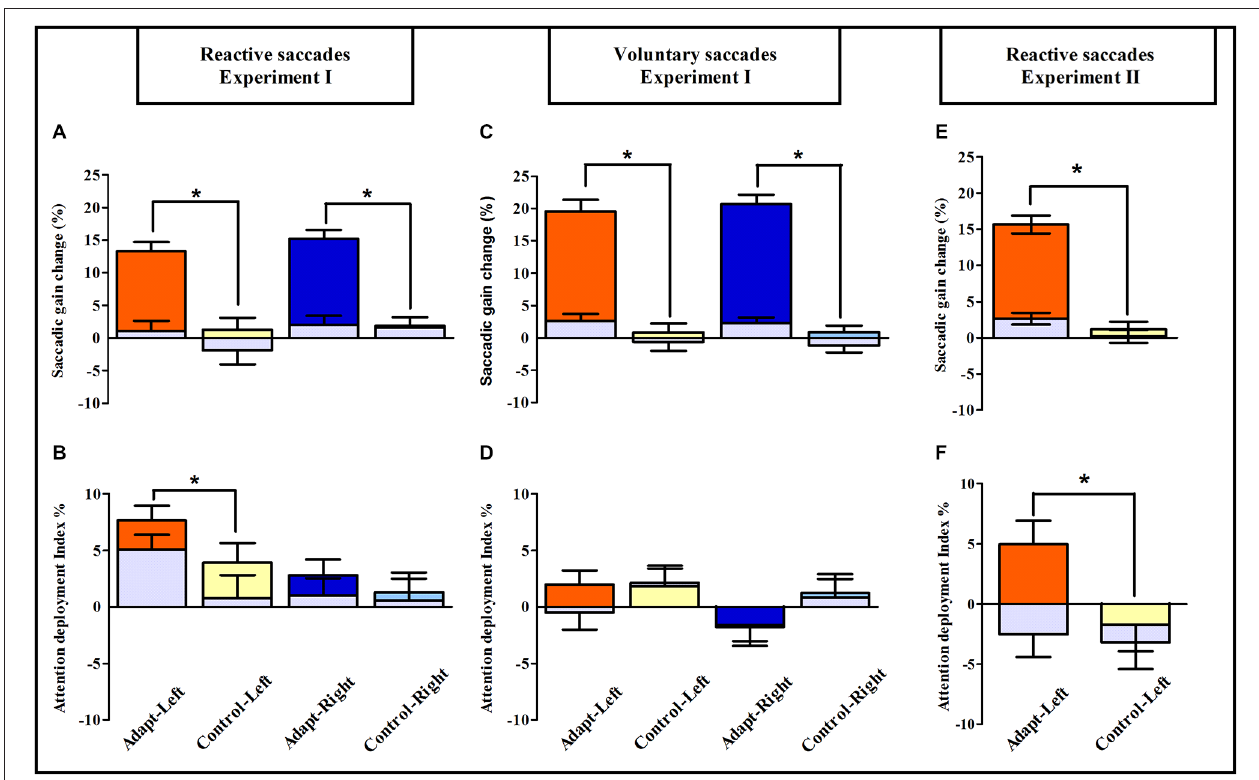
exposed hemi-fields ( post hoc LSD tests, all p < 0.0001). Error bars indicate ± 1 SEM. Lower row: the mean attention deployment index averaged across target positions is plotted separately for the Adapt-Left group (orange), Control-Left group (yellow), Adapt-Right group (blue) and Control-Right group (light blue) in the reactive (B) and the voluntary conditions (D) of Experiment I and in the reactive condition of Experiment II (F) ; gray bars represent the unexposed hemi-field. Asterisks denote significant differences between adaptation and control groups ( post hoc LSD tests, all p < 0.05). Error bars indicate ± 1